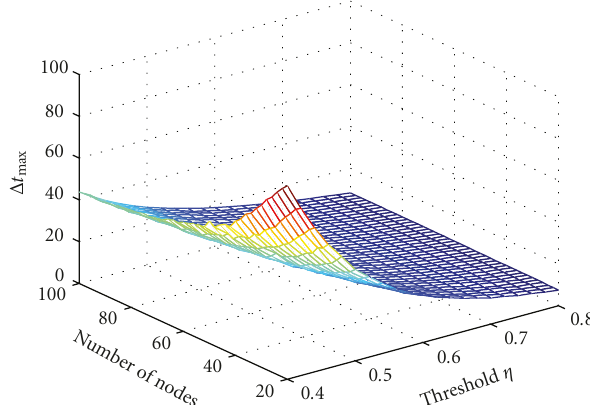
Figure 7: Disagreement evolution of the DCTS algorithm in a random network with Gaussian delay.